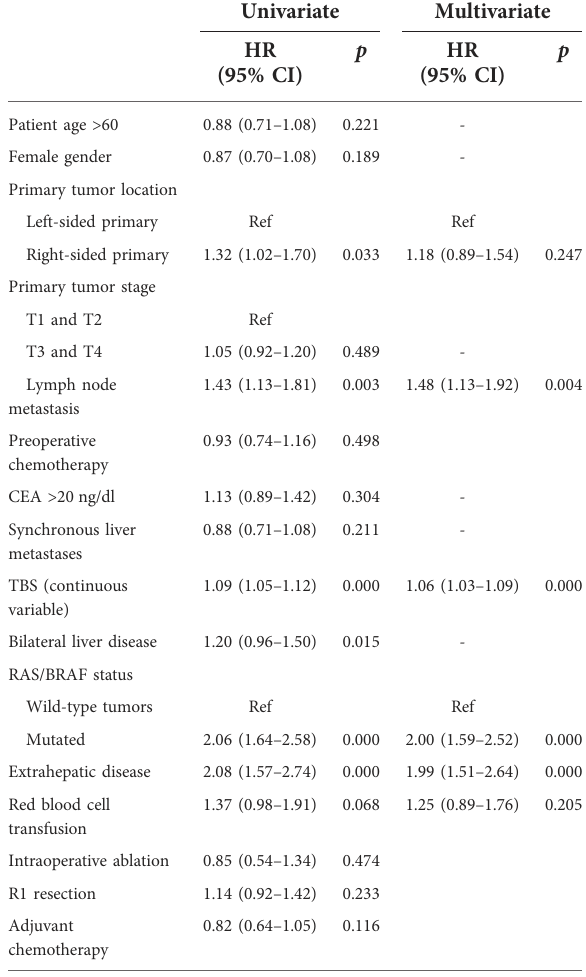
TABLE 2 Univariate and multivariate analyses for the overall survival in the entire cohort. Univariate